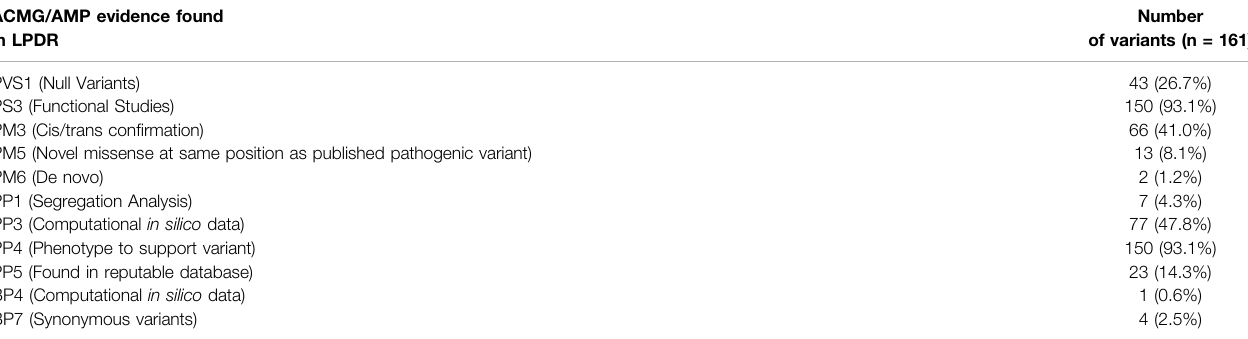
TABLE2| Numberofvariantsassignedapathogenicitycriterion.TheACMG/AMPguidelineshavevariousclinicalsigni fi cancecriteria,thatwhencombined,resultinaclinical signi fi canceclassi fi cation. ACMG/AMPscoringcriteriaareshowontheleft,withthenumberofvariantsassignedthatcriteriashownontheright.Percentagescalculated from the total number of unpublished variants (n =